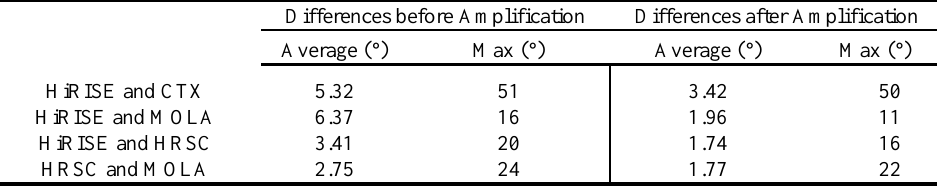
Table 1. Comparison analysis of slope maps before and after